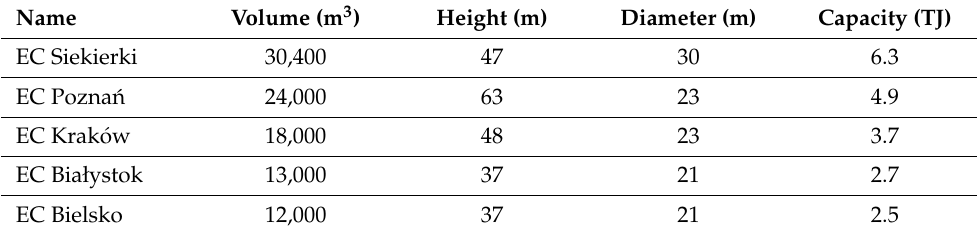
Table 2. Characteristics of selected storage systems